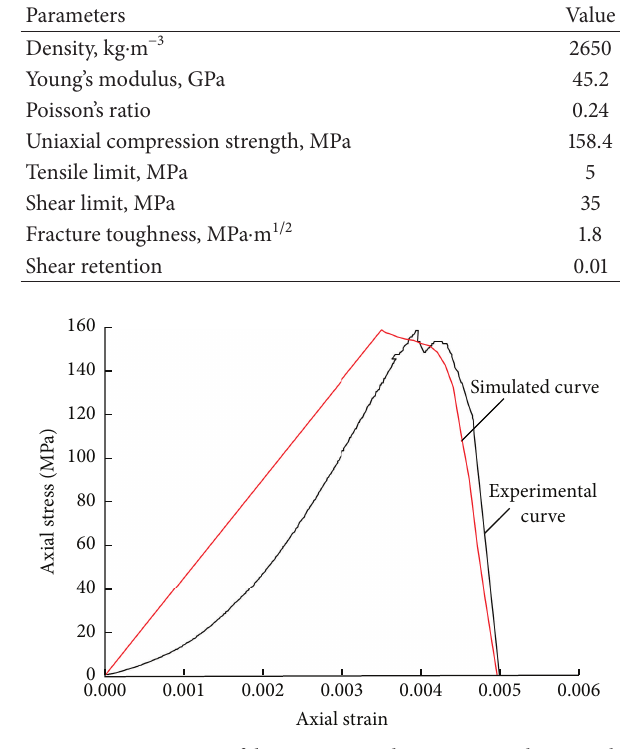
Figure4:Comparisonoftheexperimentalstressstrainrelationwith numerical